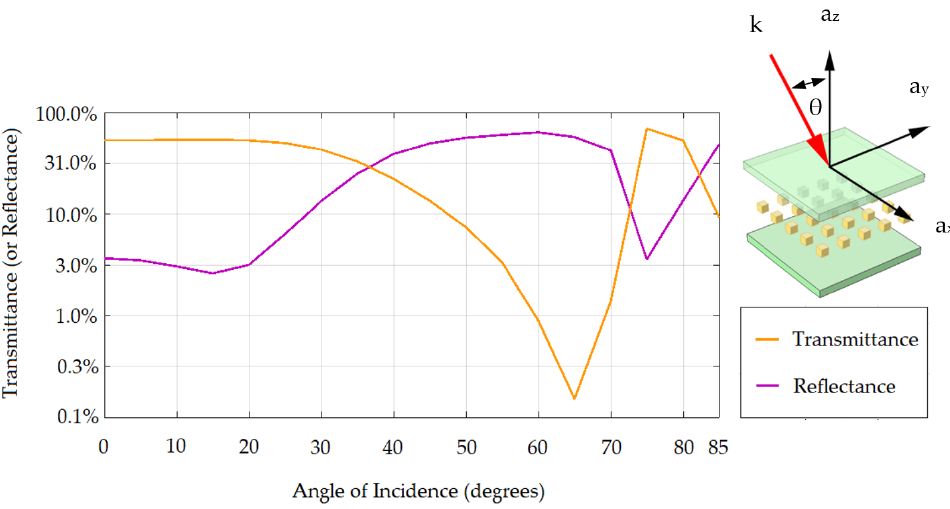
Figure 8. Transmittance and reflectance of the nanocube at optimal dimension.